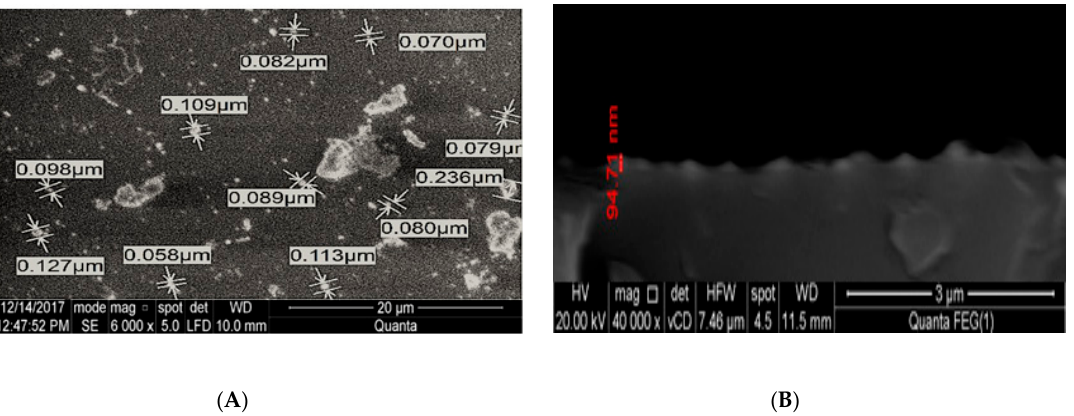
Figure 3. ( A ) FESEM of In 0.1 Ga 0.9 N thin film prepared by Nd:YAG laser and ( B ) the cross section of the deposited thin film.